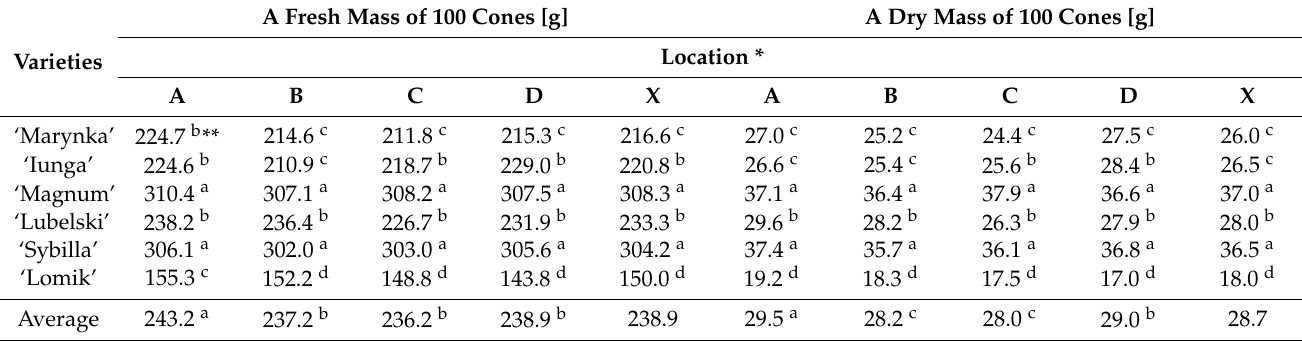
* Explanations as in Table 8. ** Letter indicators at the means (significant groups) define the so-called homogeneous (statistically homogeneous) groups. The presence of the same letter index with the means (at least one) means that there is no statistically significant difference between them. The subsequent letter indices a, b, etc., define the groups in ascending order.